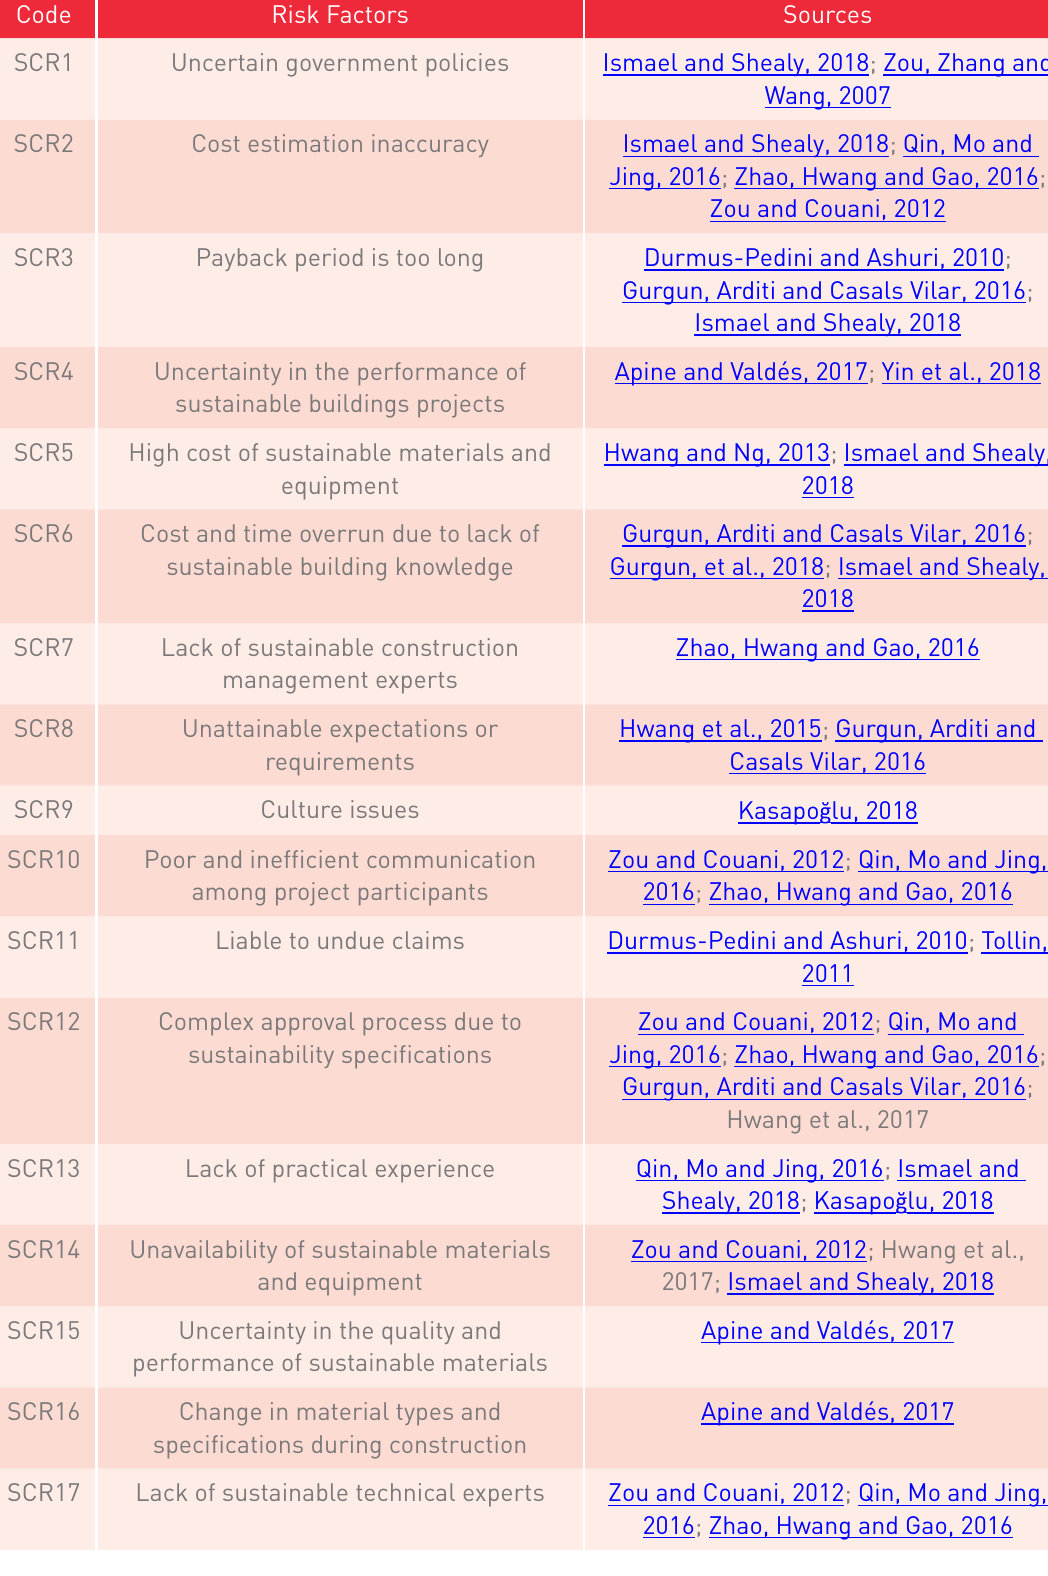
Summary of Risks Associated with Implementing Sustainable Construction